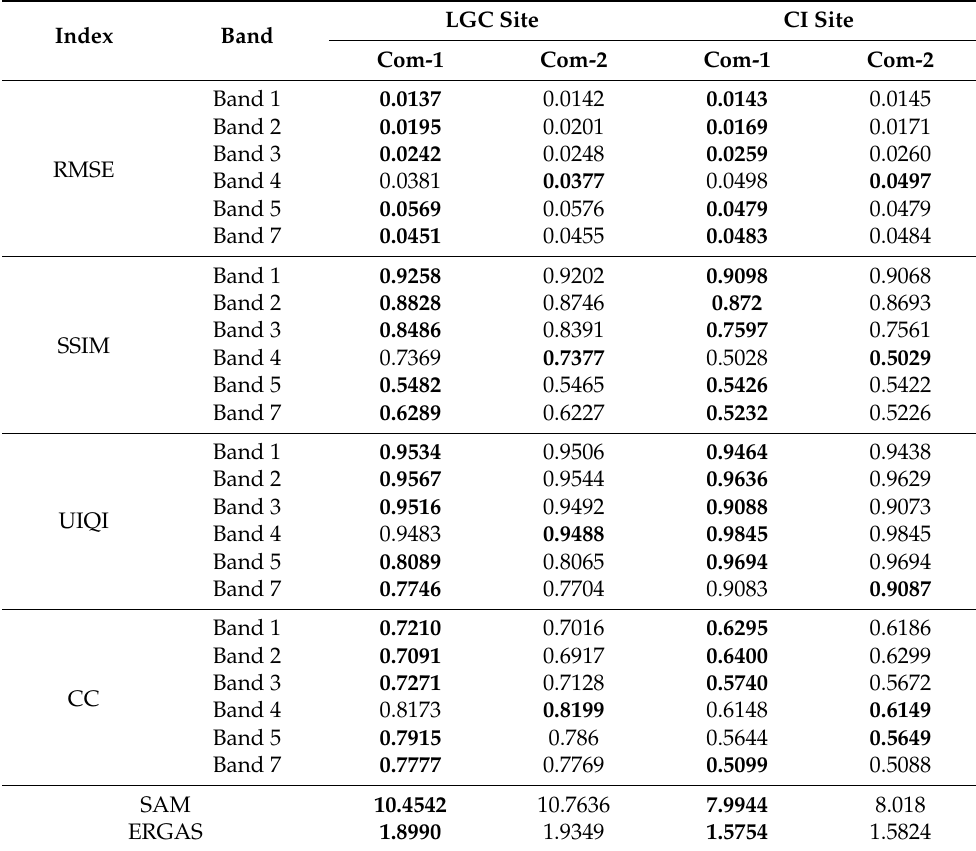
Table 5. Quantitative results of the sliding window-combination (Com-1) and CLS-combination (Com-2) methods applied to the LGC and CI sites. Bold values indicate best